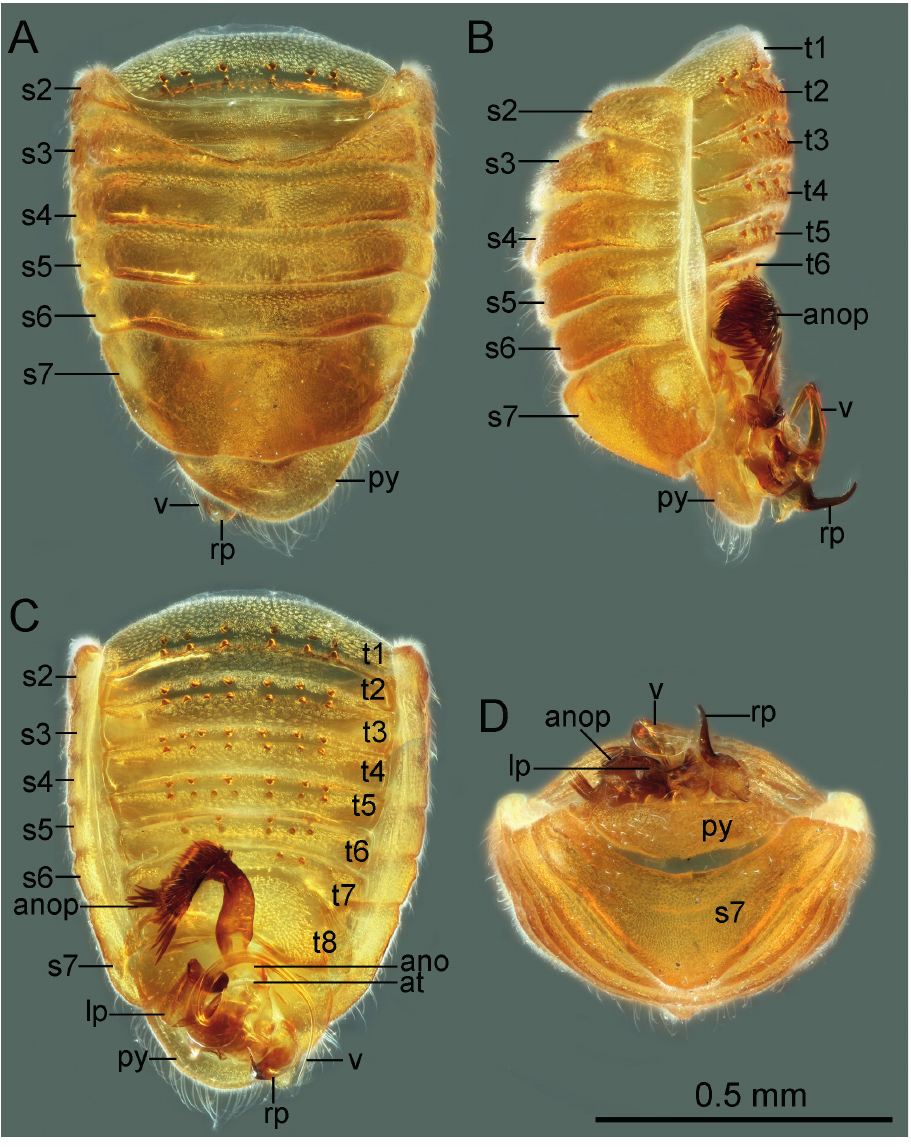
Figure 4. Abdomen of Cornonannus bui gen. et sp. nov., male paratype. A in dorsal view B in lateral view C in ventral view D in caudal